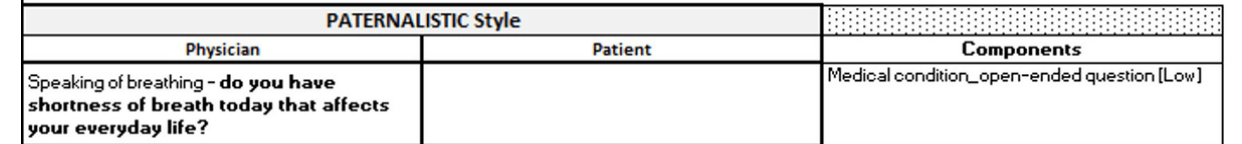
Figure 2. An example of the developed script for the paternalistic version of the conversational agent (CA) Robo is shown here. The column labeled “Components” depicts the applied communication item and its respective communication frequency for the respective interaction style. The column labeled “Physician” describes what the CA Robo says, whereas the column “Patient” shows the reply options of the